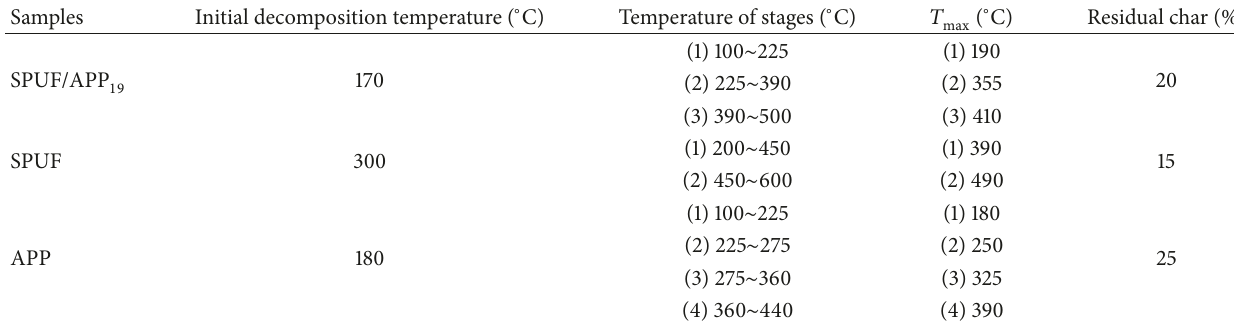
Table 2: Details of TG and DTG